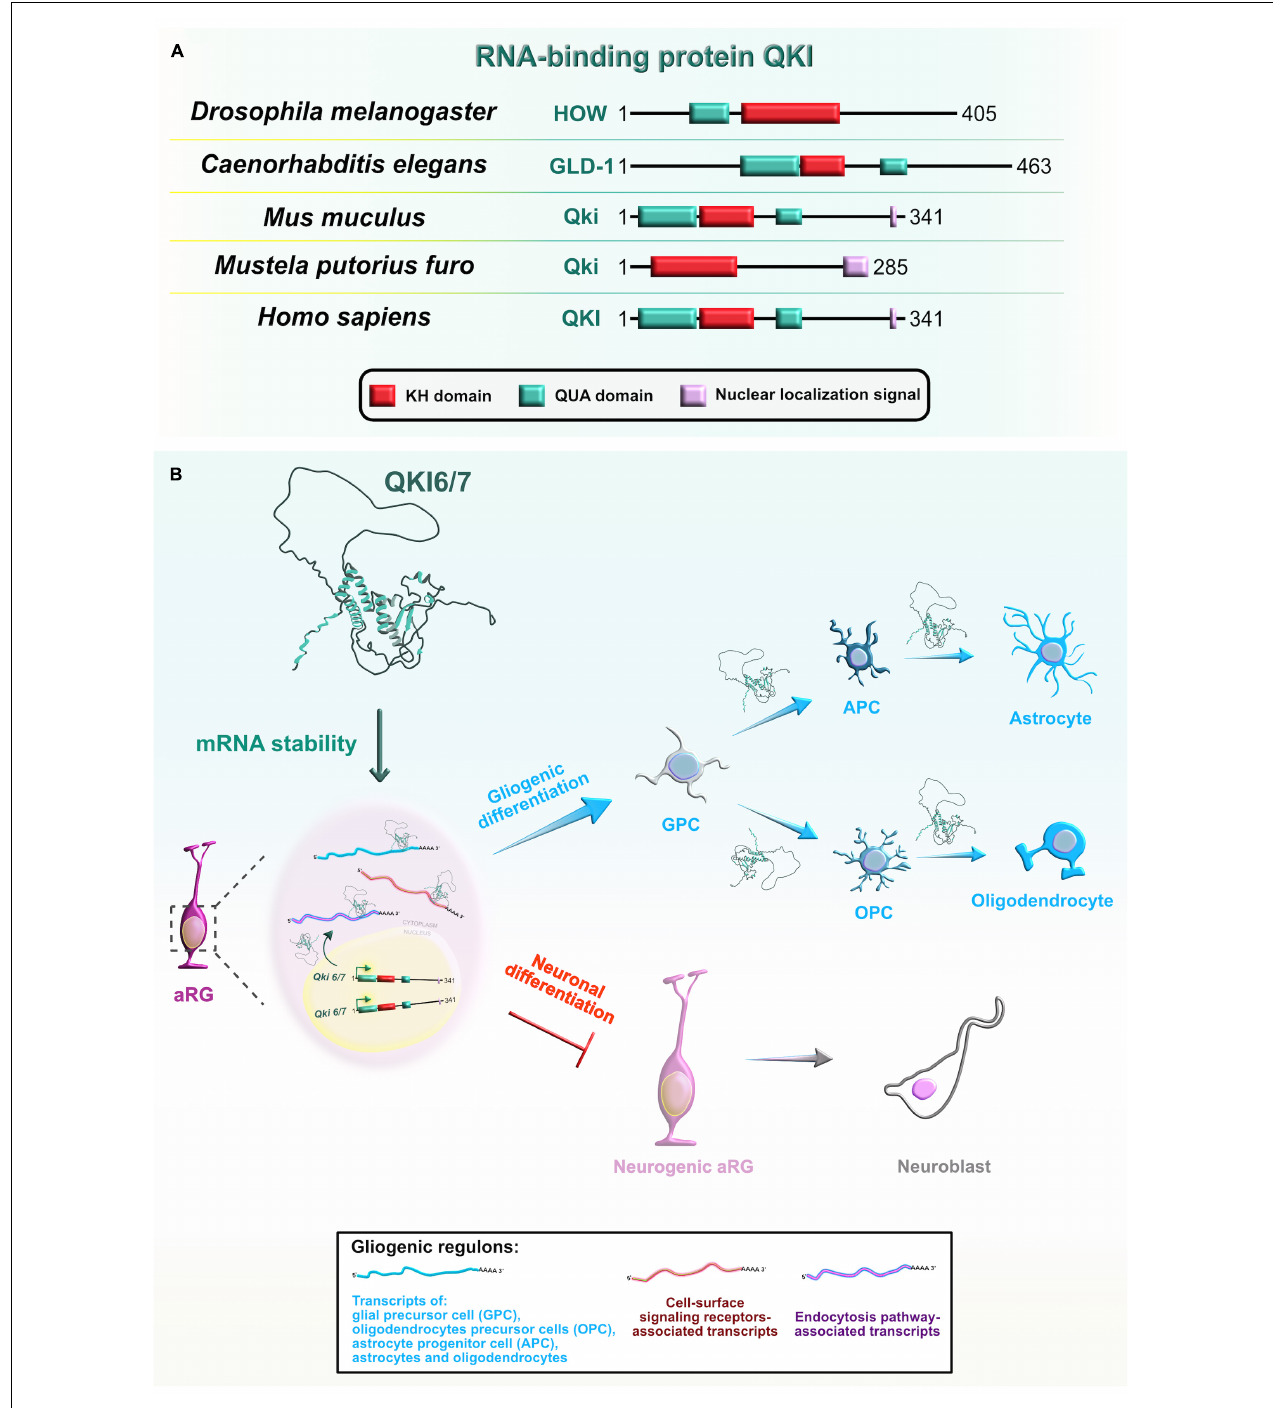
FIGURE 9 | Evolutionarily conserved RNA-binding protein Quaking (Qki) and its role during later stages of neocortical development. (A) Domain structures of Qki in Drosophila melanogaster , Caenorhabditis elegans , Mus musculus , Mustela putorius furo , and Homo sapiens according to https://www.uniprot.org or https://www.ncbi.nlm.nih.gov/. The RNA-binding motif K homology (KH) domain is colored in red, Quaking (QUA; QUA1 involved in homodimerization and QUA2 involved in RNA binding) domains are labeled in cyan, and nuclear localization signal motif is in rose. The UniProtKB of NCBI accession numbers are indicated below for Qki protein in D. melanogaster : held out wings (HOW) (NP_524447.2); C. elegans : Germline Defective-1 (GLD-1) (Q17339), M. musculus : Qki (Q9QYS9); M. putorius furo : Qki (XP_004769624.1); and H. sapiens : QKI (Q96PU8). (B) Qki is selectively expressed in proliferative regions in the developing neocortex where it promotes the cell fate switch from neurons toward glial cells. Qki synergistically controls the expression of gliogenic regulons (shown in box at bottom center) by binding targets’ 3 (cid:48) UTRs and stabilizing target mRNAs associated with glia-, astrocyte-, oligodendrocyte precursor-, astrocyte precursor-, oligodendrocyte-, and astrocyte-specific genes, as well as cell-surface signaling receptors, and endocytosis pathway genes.